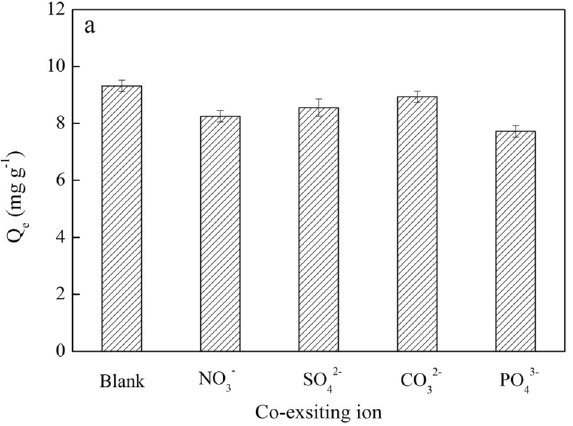
Figure 4. The effect of co-existing anions on Cr(VI) adsorption. [Concentration of Cr(VI) = 20 mg L −1 , solution volume = 50 mL, pH = 2.0, adsorption time = 48 h, temperature = 25 °C, concentration of NO 3− , CO 32− , SO 42− , and PO 43− = 10 mg L −1